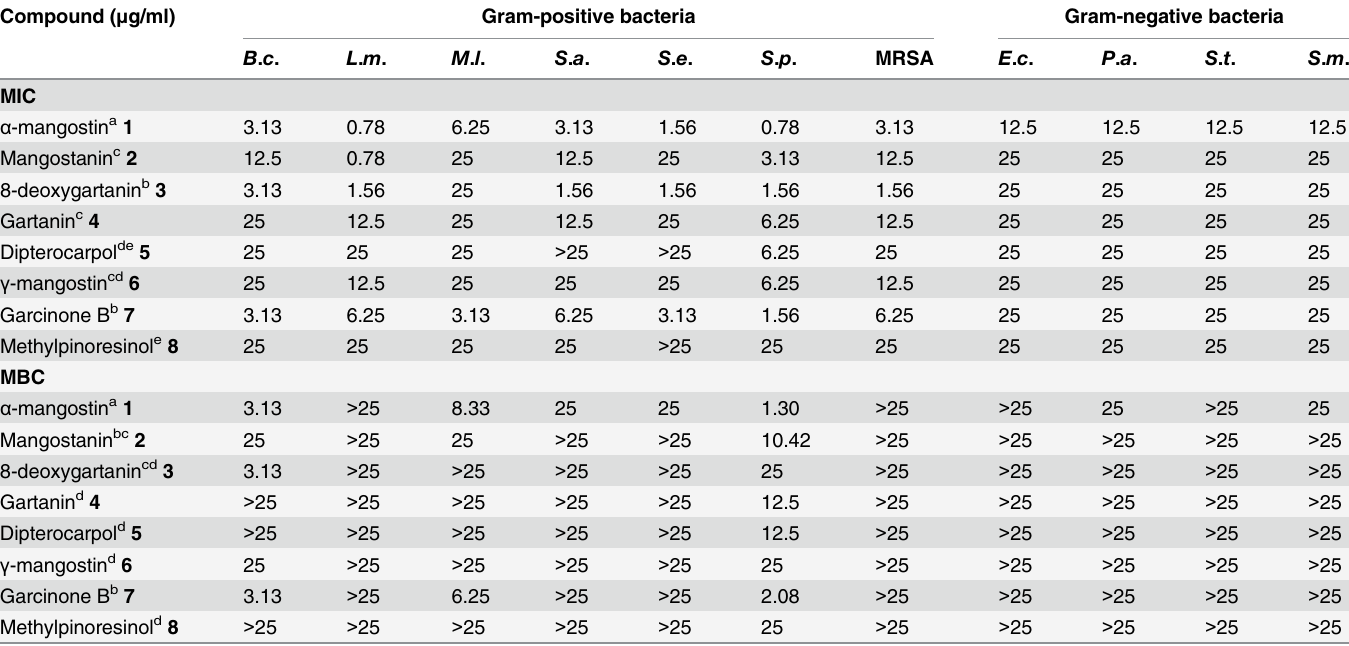
Table 1. Antimicrobial activities of isolated compound from Tetragonula laeviceps